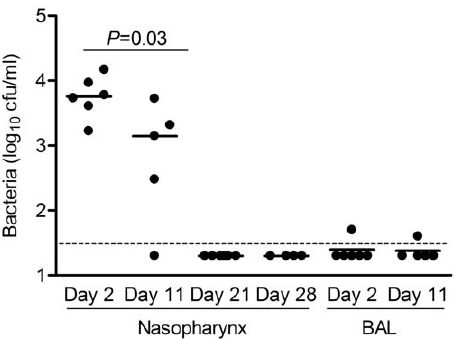
Figure 1. S.pneumoniae D39 colonises the nasopharynx of CBA/ Ca mice. Bacterial cfu recovered from nasal washes and BALF 2, 11 and 28 days following intranasal inoculation in 10 m l of PBS with 10 7 cfu D39 S. pneumoniae . Each dot represents results for an individual mouse and bars the median for each group. The dotted line is the limit of